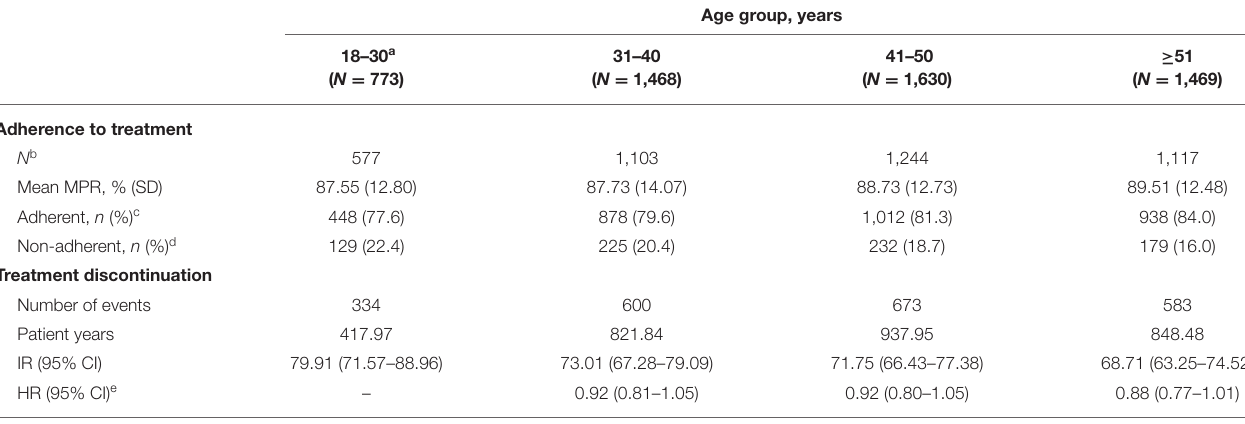
a Reference group for treatment discontinuation. b Patients with data available for calculating